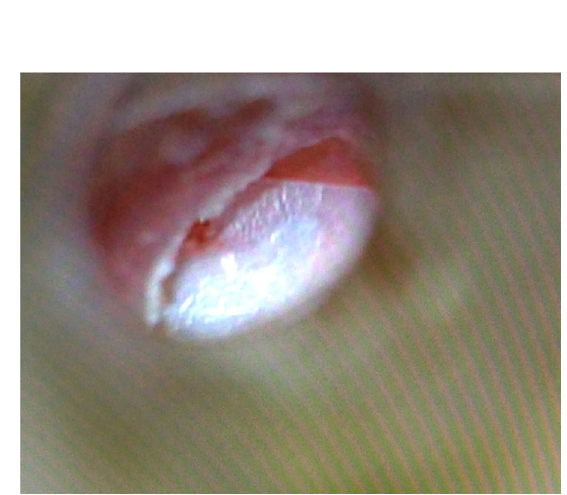
Otoendoscopy of bacterial cellulose graft over TMP.